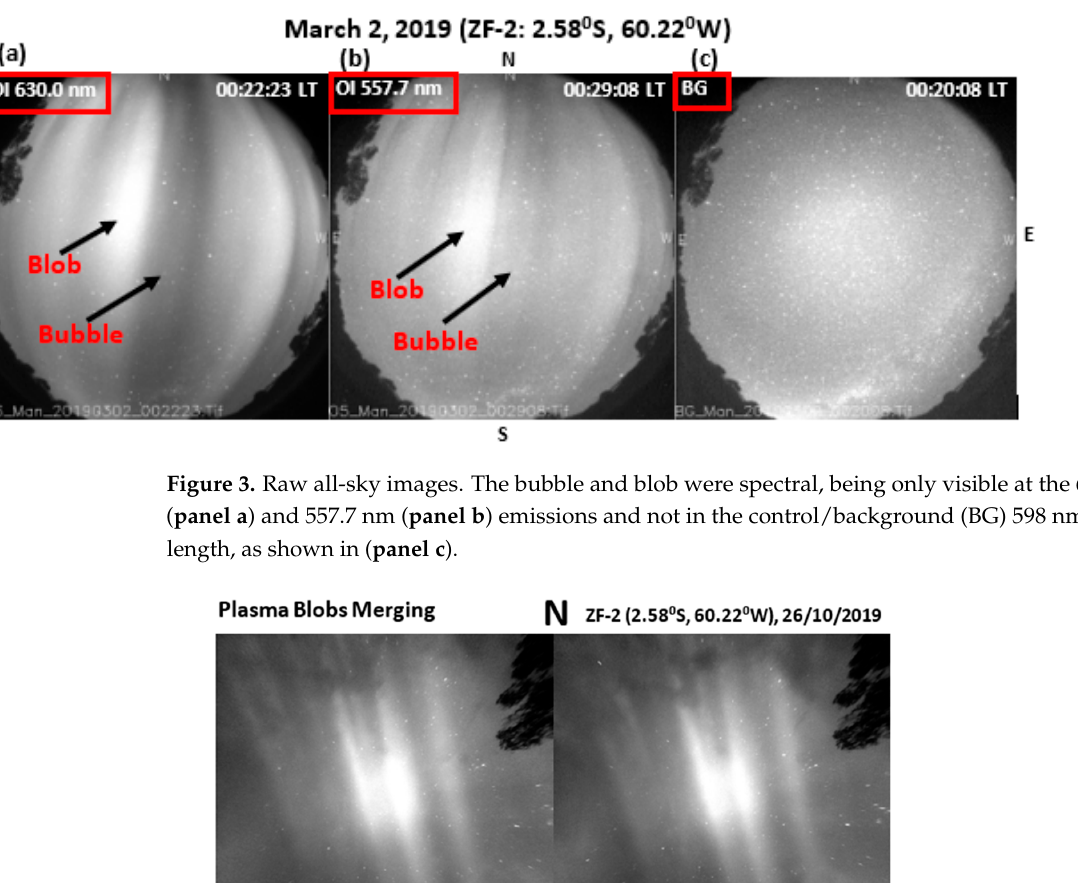
Table 1. Dates of events studied.